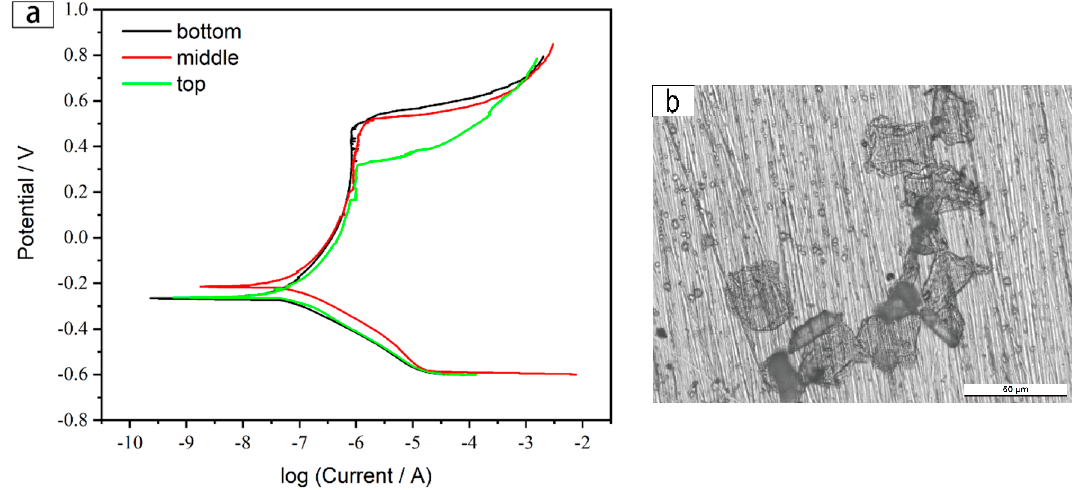
Figure 16. Electrochemical test results of the as-deposited wall: ( a ) Potentiodynamic polarization curve of the three regions, and ( b ) corrosion pit morphology. Table 3. The test results of potentiodynamic polarization curve (corrosion potential, corrosion current density, and pitting potential).